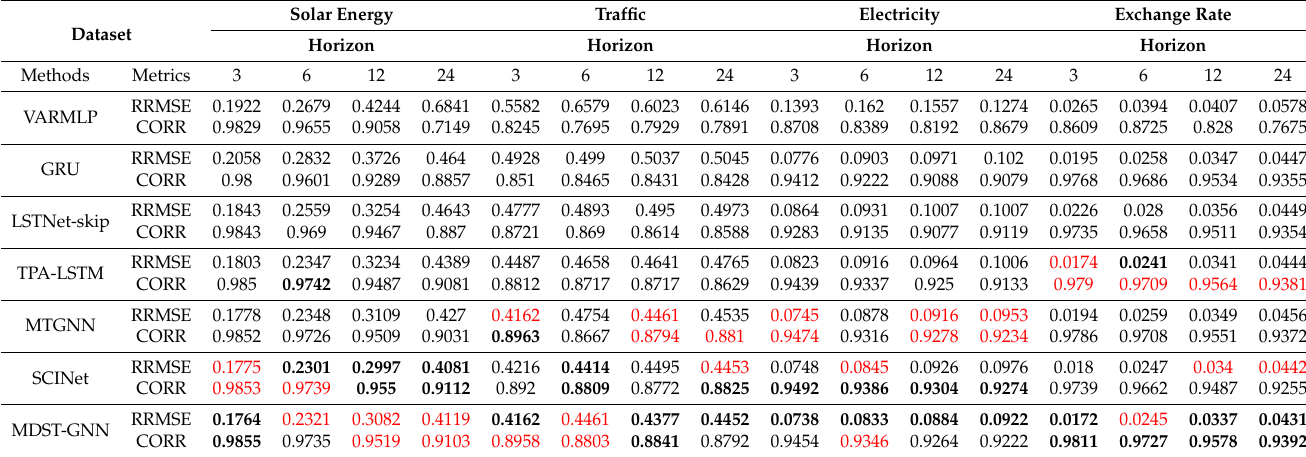
Table 3. Comparison of forecasting methods for multivariate time series methods.